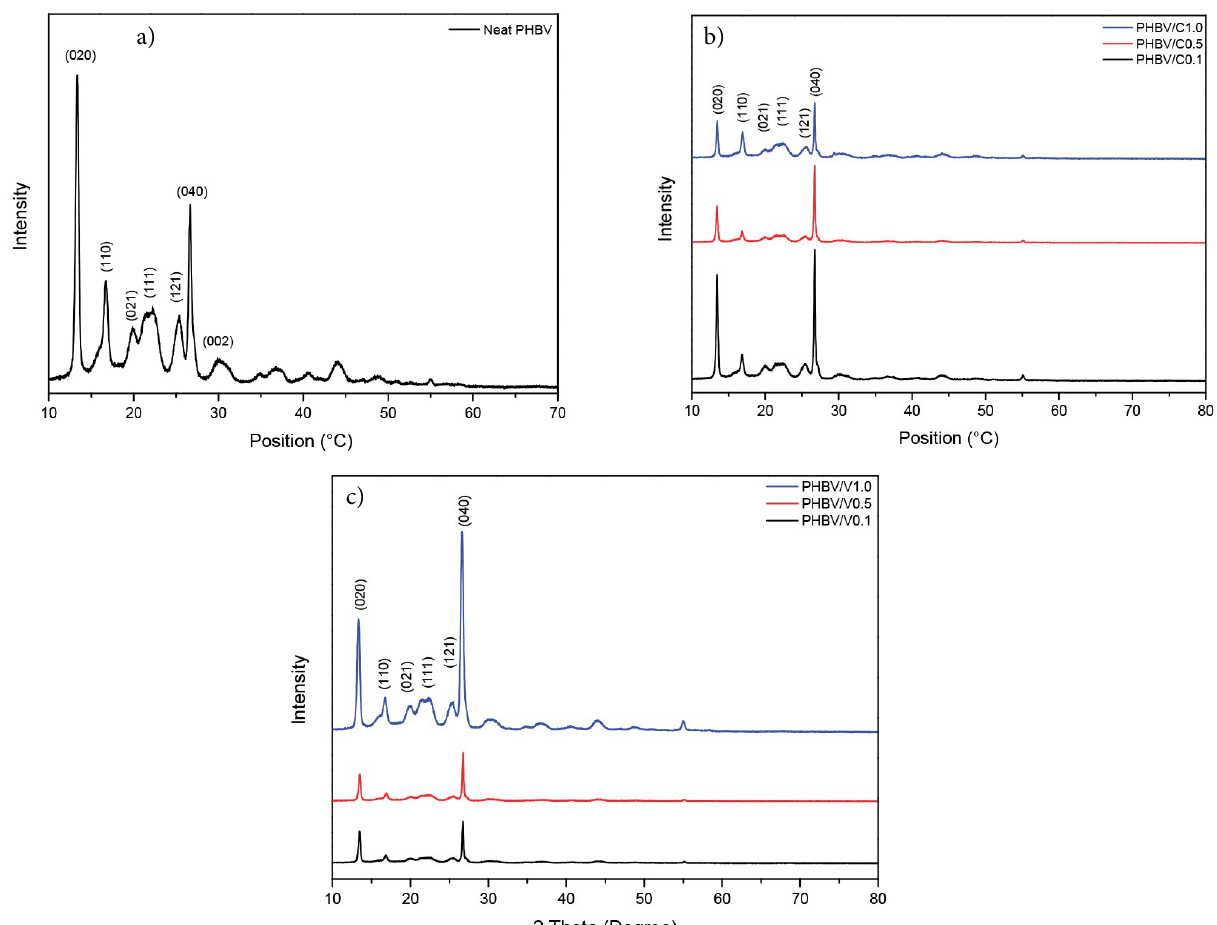
Figure 5. The X-ray diffraction pattern of (a) Neat PHBV, (b) PHBV/C composites and (c) PHBV/V